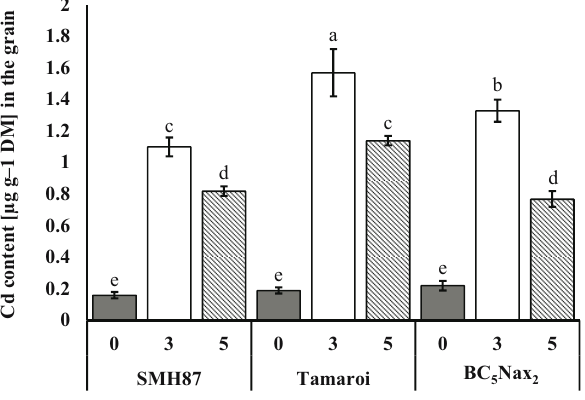
Figure 6: Cd content ( µg g − 1 DM ) in the grains of three durum wheat genotypes grown in the soil contaminated with Cd at 0 mg ( control ) , 3 and 5 mg kg − 1 DM. Data are represented as mean ± SE in fi ve replicates. Means with di ff erent letters ( a, b, c, … ) are signi fi cantly di ff erent at P < 0.05 using the Duncan multiple range